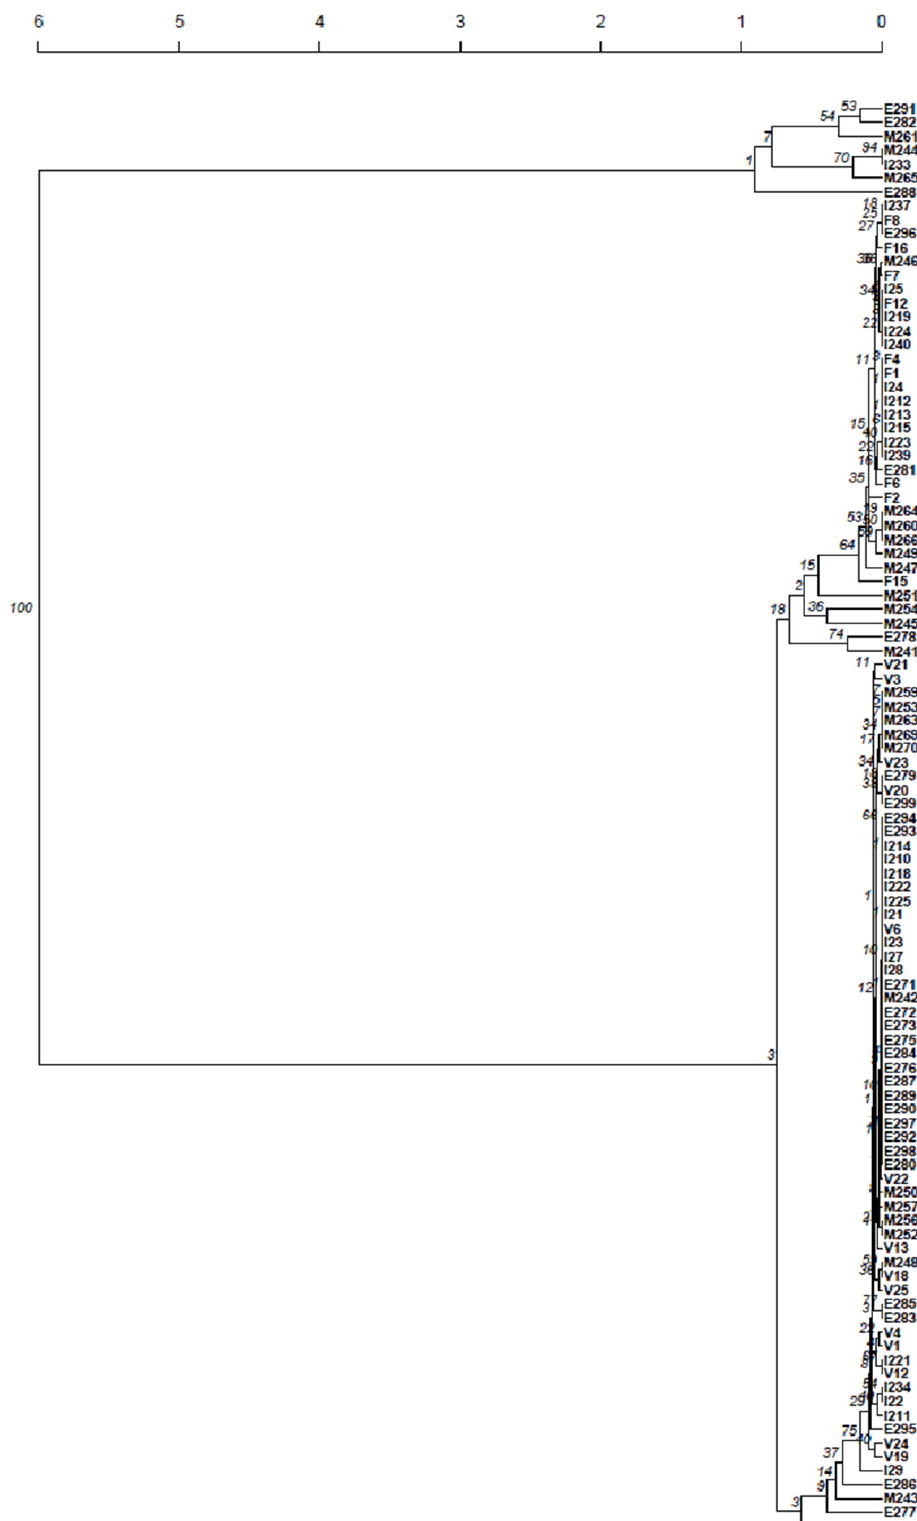
Figure 3. Dendrogram presenting the genetic distance between the isolates from Experiment 2, modality 3 and the ADY isolates, based on the microsatellite profiles. V—ADY V isolates; F—ADY F isolates; isolates from fermentation are represented by a letter; I—initial, M—middle or E—end time periods of fermentation, followed by the number of the isolate. Scale at top represents genetic distance.